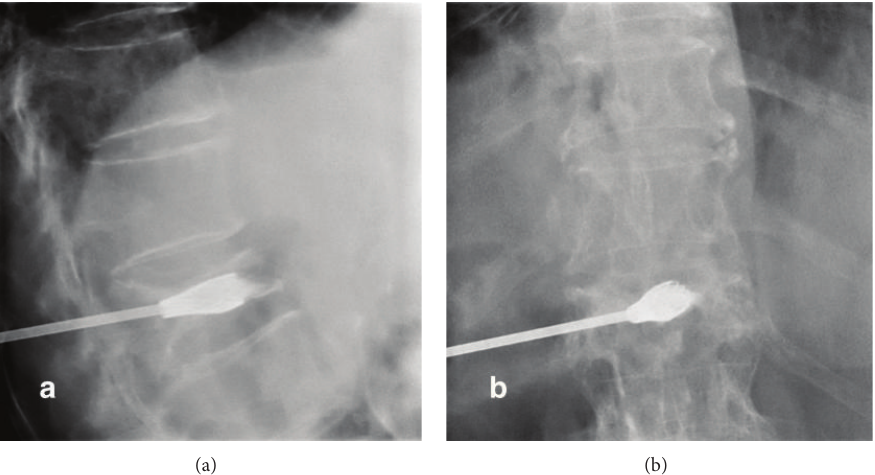
Figure 4: AP and lateral ((a) and (b)) fluoroscopic projections showed the placement of intravertebral cement inside the device previously deployed.